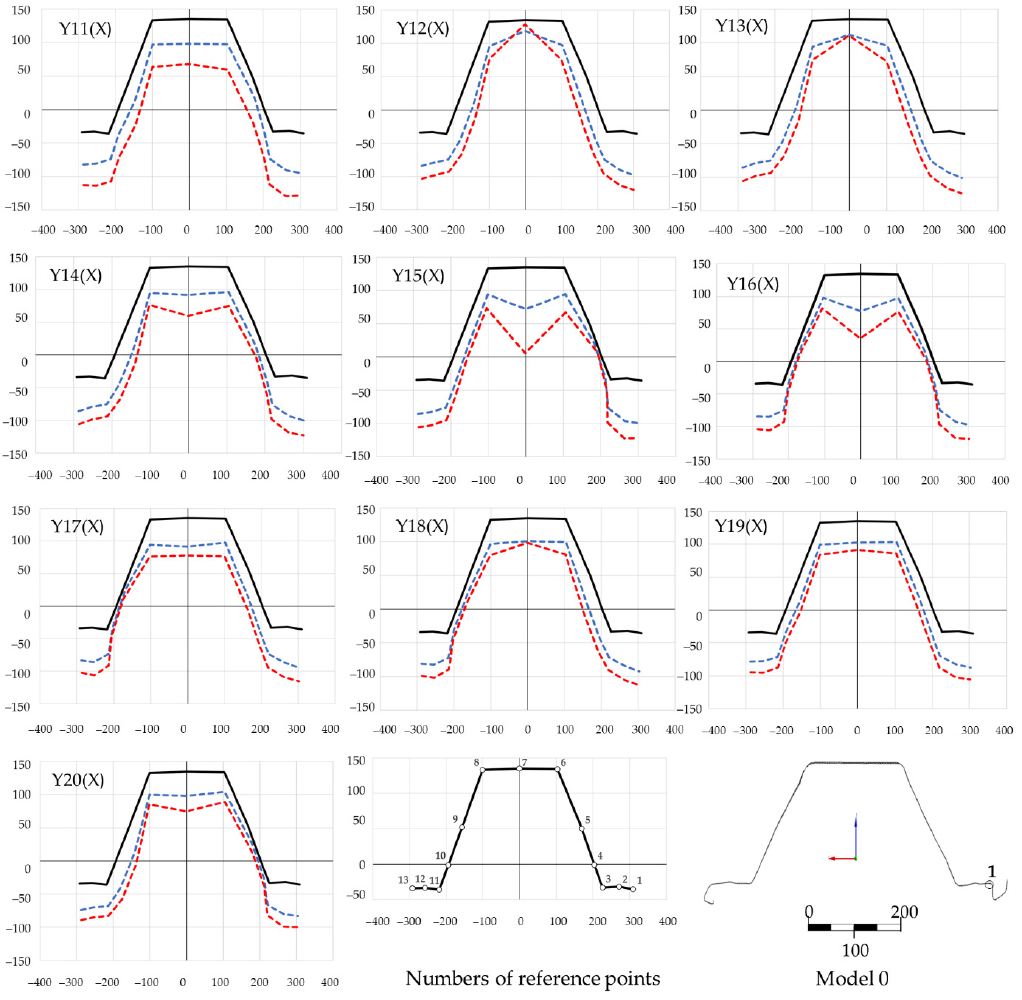
Figure 16. The cross-section deformations, two stages of loading: phase IIa (time: 5.4) and IIb ( blue line ), time: 7.4 ( red line ).